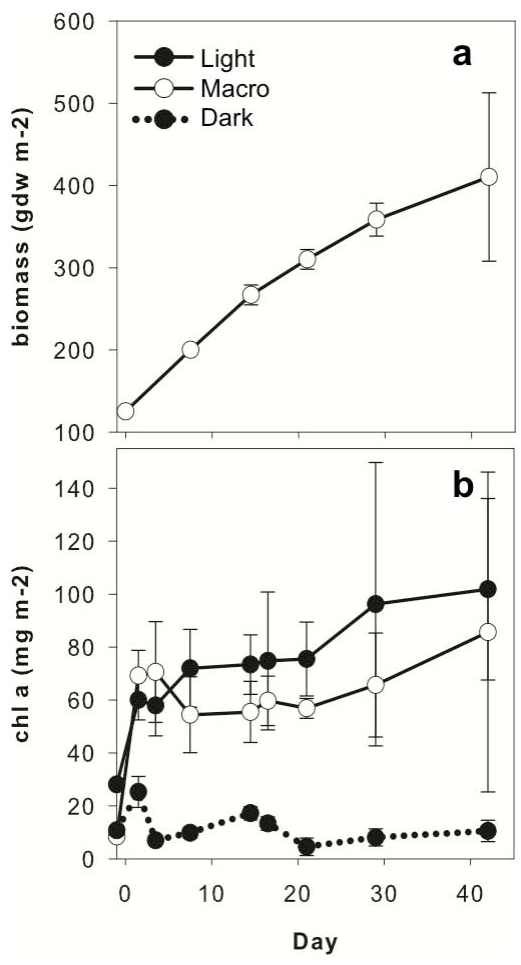
Fig. 1. Macroalgal biomass (a) and benthic chlorophyll a concen- trations for surface (0–1cm) sediments (b) . Treatments shown are light with macroalgae (“Macro”; solid lines, filled symbols), light without macroalgae (“Light”; solid lines, open symbols), and dark without macroalgae (“Dark”; dotted lines with filled symbols). Val- ues are mean ± SE ( n = 4).